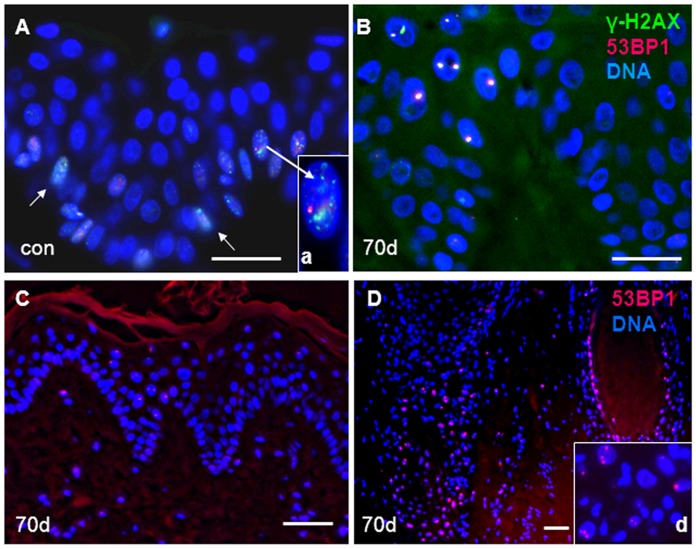
(A) Non-irradiated control skin (con) showing nuclei (blue) with numerous small γ-H2AX (green) and fewer 53BP1 (red) foci in cells at the basal layer of the epidermis (arrows) indicating γ-H2AX formation due to collapsed replication forks in S-phase cells.Such replicating nuclei (compare Fig. 4) with numerous small γ-H2AX foci (inset, arrow) were excluded from the enumerations of all time points. (B-D) Skin sections 70 days after IR. (B) Keratinocyte nuclei of the epidermis displaying one or two large RIFs with γ-H2AX and 53BP1 colocalization due to complex DNA damage in nuclei of the basal and spinous layer. (C) Epidermis at lower magnification with 53BP1 RIF carrying nuclei in all layers. (D) Many nuclei of hair sheath cells carry strong and numerous 53BP1 RIF. The inset displays magnified part of the hair bulb compartment. Magnification bar: 20 µm.